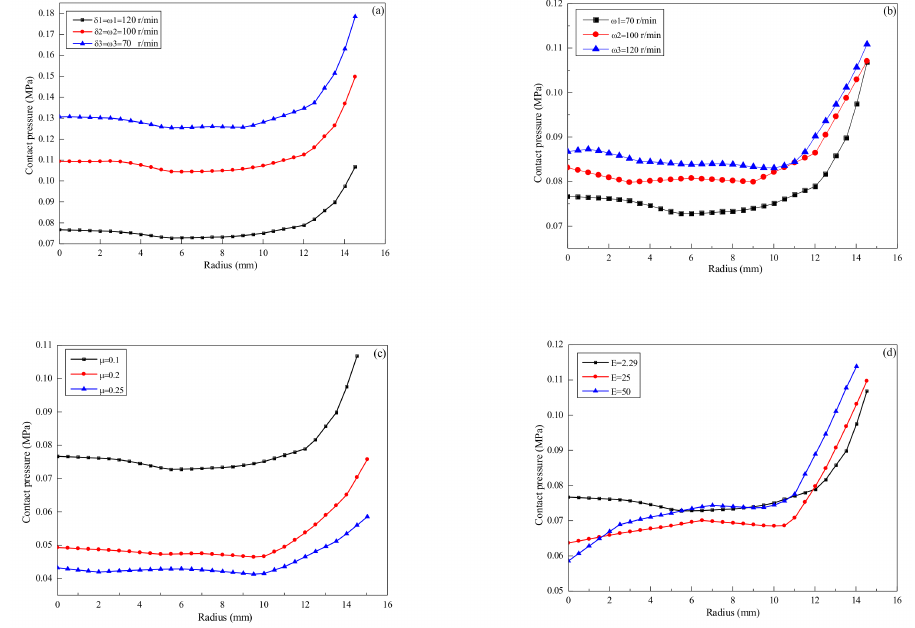
Figure 5. Distribution of contact pressure on the SiC specimen surface at different parameters. ( a ) Speed (specimen and polishing plate rotate at equal speed); ( b ) speed (keeping the speed of the polishing disc as 100 r/min, changing the speed of the specimen); ( c ) Poisson’s ratio of polishing pad; and ( d ) elastic modulus of polishing